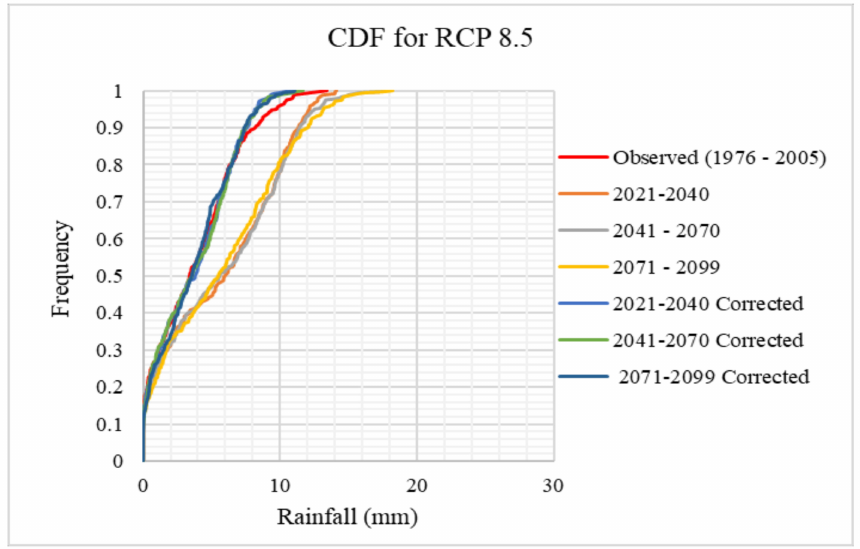
Figure 4. The CDFs of projected daily rainfall under RCP 8.5 before and after bias correction. Table 3. Statistical evaluation of bias corrected rainfall data (1976–2005).